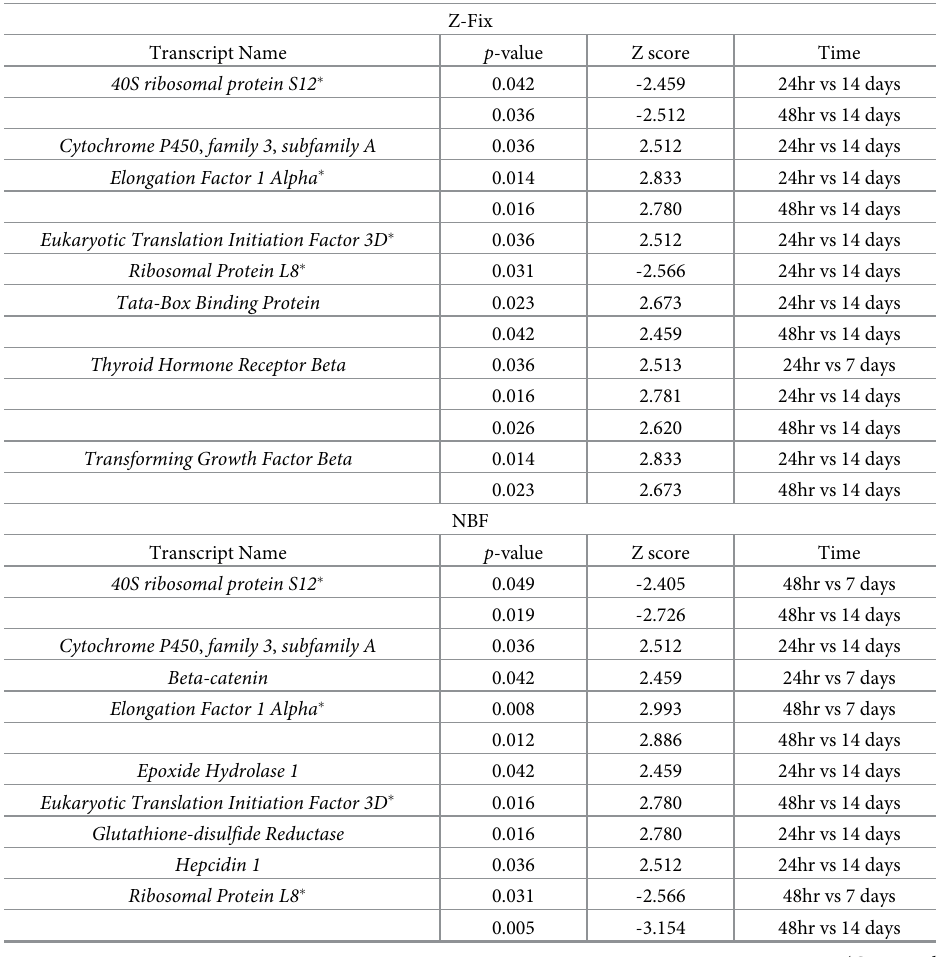
Table 3. Kruskal-Wallis non-parametric ANOVA results: Significant differences in transcript abundance between fixation times for each